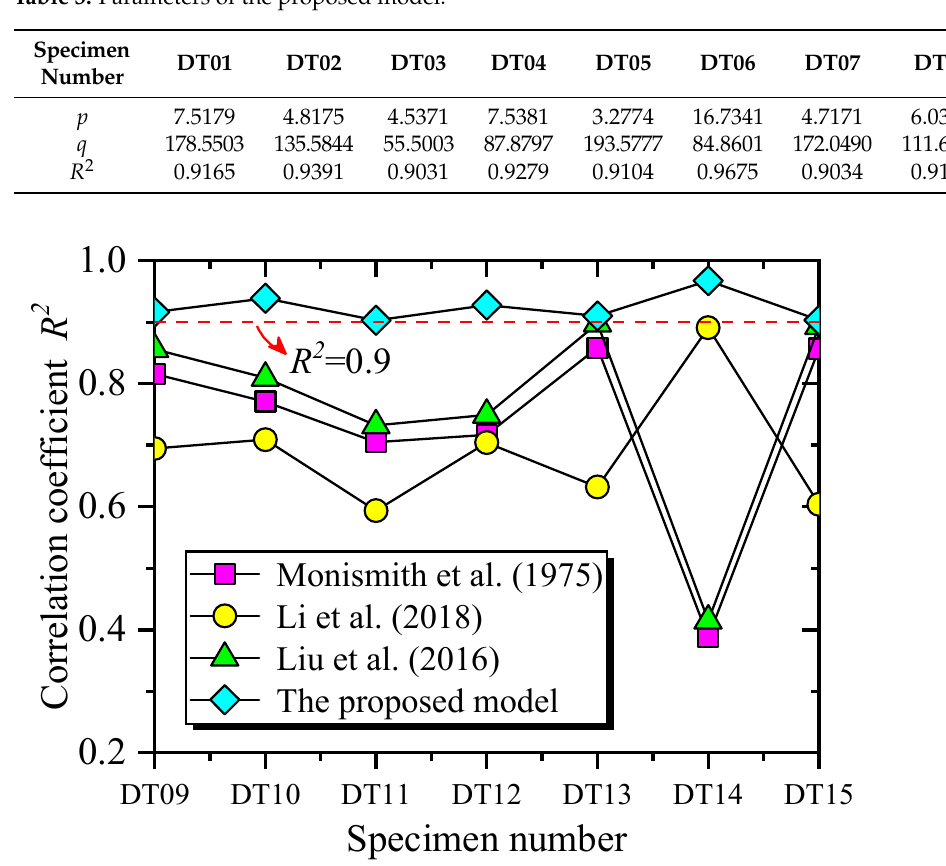
Figure 11. Correlation coefficient comparison of permanent deformation models [35,40,41].